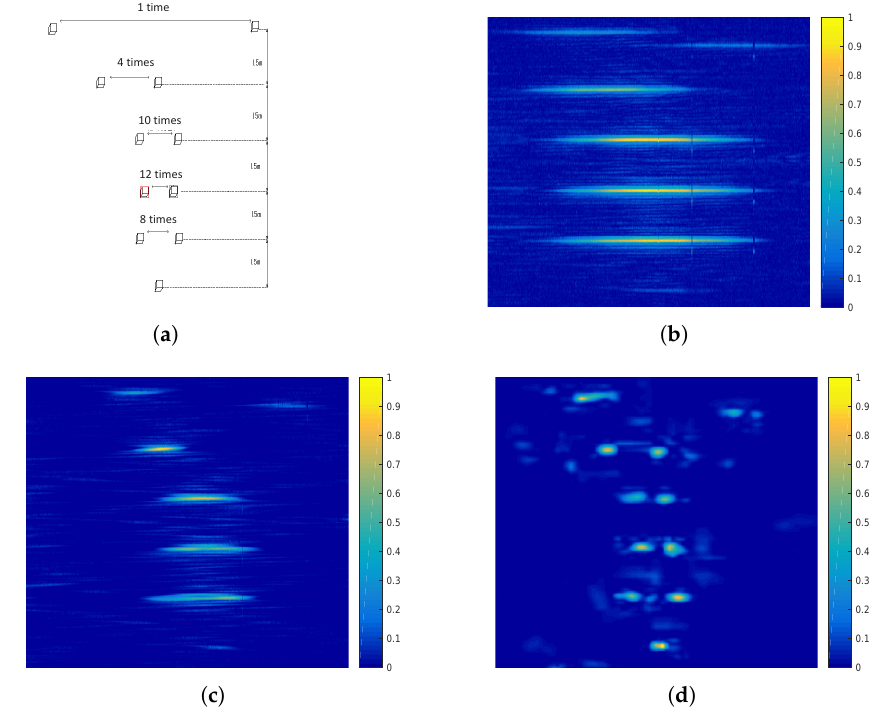
Figure 9. Processed results of real measured data. ( a ) The distribution of corner reflectors. ( b ) Real aperture image after pulse compression in the range dimension. ( c ) Superresolution result processed by the Poisson-based MAP algorithm. ( d ) Superresolution result processed by the proposed